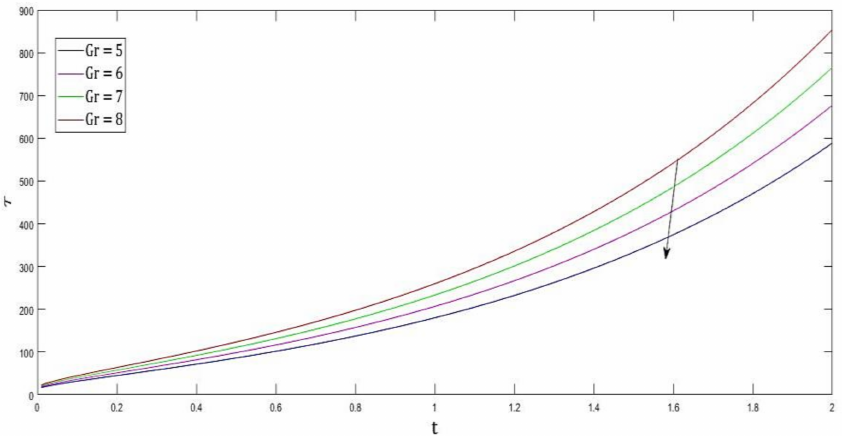
Figure 14. Variation in skin friction with respect to Grashof number.